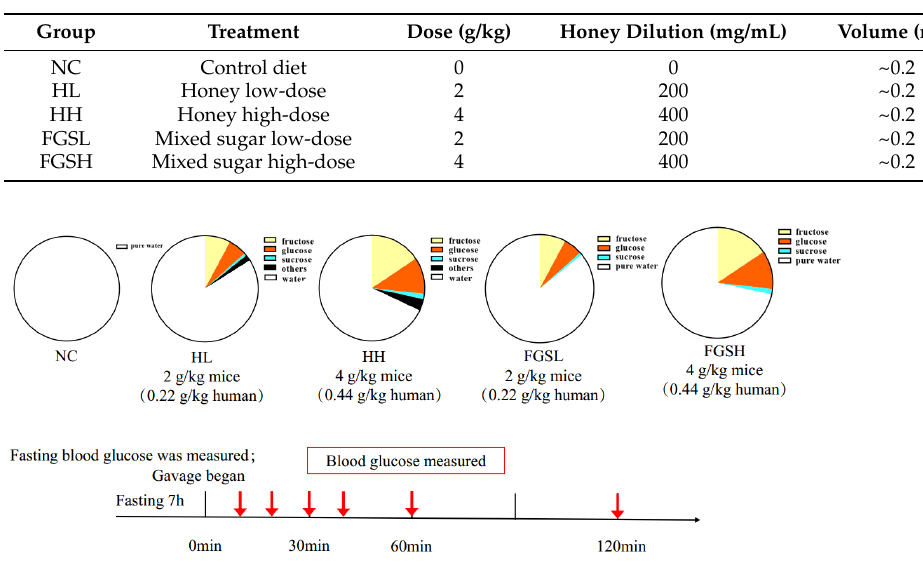
Table A1. Animal groups and dosages of single dose.